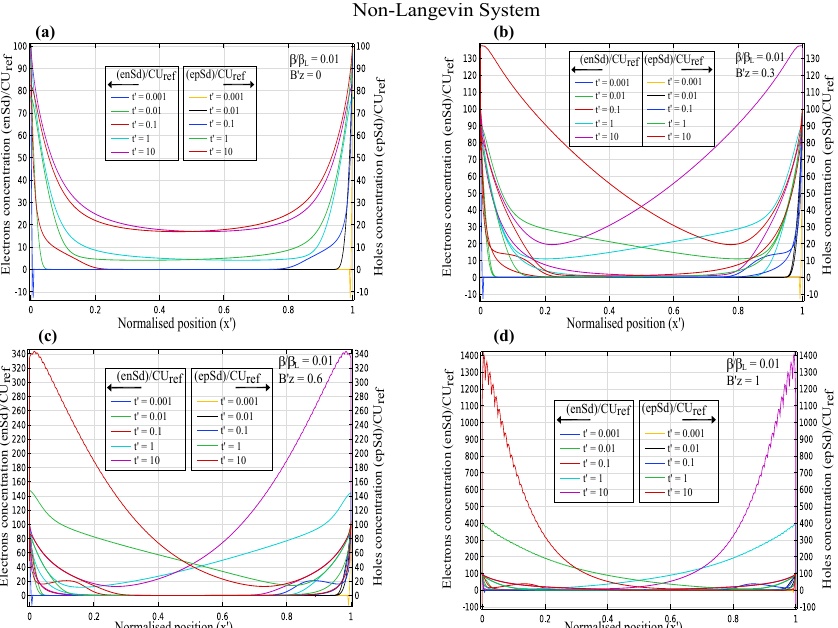
Figure 2. Time-dependent charge carrier concentration for electrons and holes as a function of normalised position x (cid:48) with varying magnetic fields of ( a ) B (cid:48) = 1 for non-Langevin system with β ( d ) B (cid:48) z Figure 2 demonstrates that for the non-Langevin system of β hole concentrations decreased initially with increasing times t (cid:48) = 0.001, 0.01, and 0.1, then increased for times t (cid:48) = 1 and 10, and reached maximum values of about 100, 130, 340, and 1400 for magnetic fields of 0, 0.3, 0.6, and 1, respectively. Hence, the charge concentration increased with increasing magnetic fields and times.